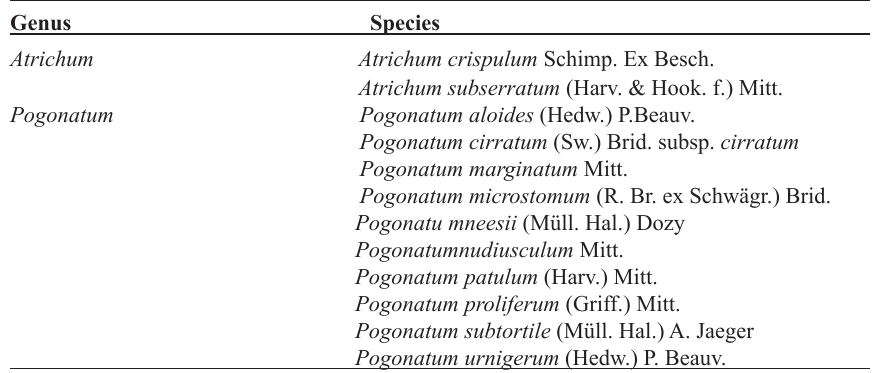
Table 1: Synopsis of genera and species of Polytrichaceae Schwägr. in Sri Lanka from O’Shea (2002). Genus Species Atrichum Atrichum crispulum Schimp. Ex Besch. Atrichum subserratum (Harv. & Hook. f.) Mitt. Pogonatum Pogonatum aloides (Hedw.)